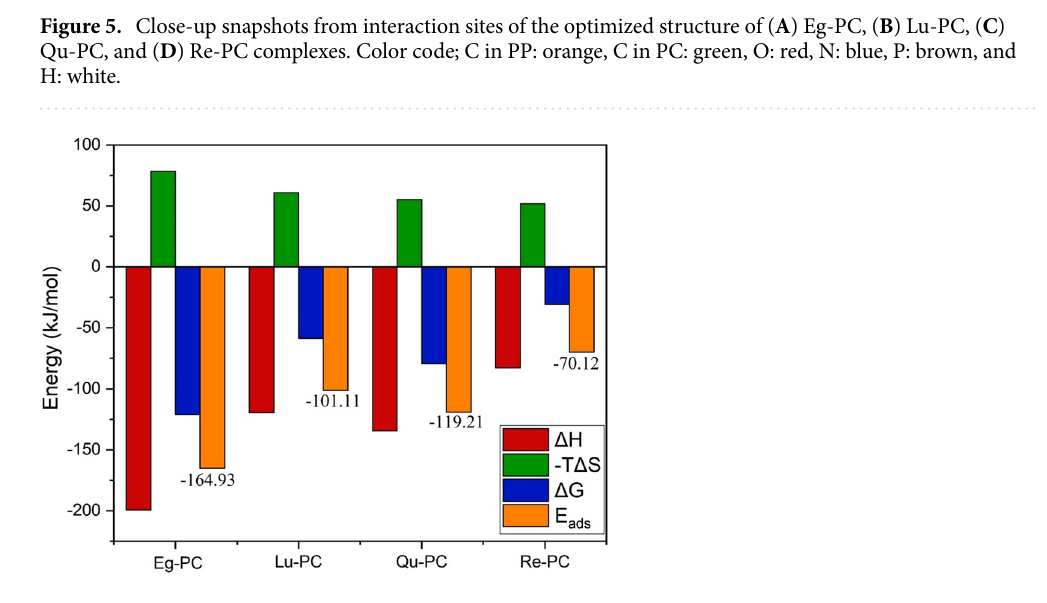
Figure 6. Thermodynamic parameters and adsorption energy of the studied